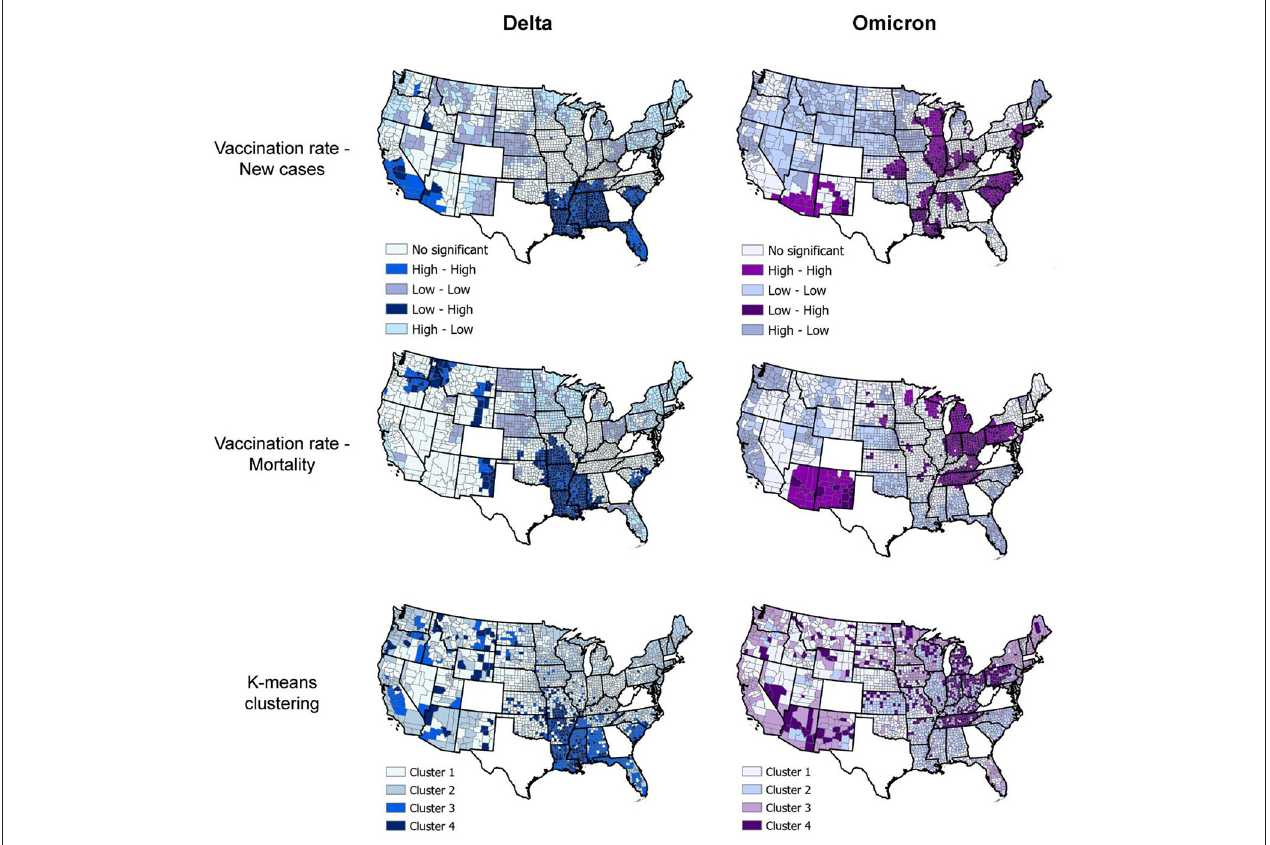
FIGURE 4 | Geospatial clustering of COVID-19 incidence and mortality rates. Bivariate local indicators of spatial autocorrelation and K-means clustering analysis maps for the association between vaccination rate and new COVID-19 cases and deaths per 100,000 people during the Delta (July 1, 2021, to August 31, 2021; blue maps) and Omicron (December 1, 2021 to January 31, 2022; purple maps) in the US. K-means cluster information is summarized in Table 1